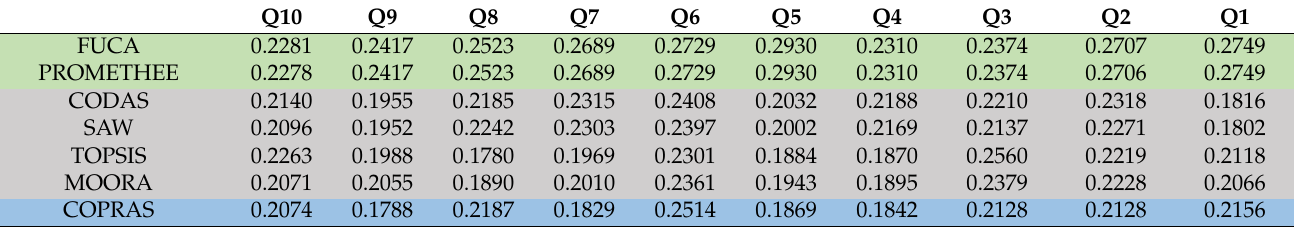
Table 7. SD Values of Firms’ MCDM based Financial Performance Scores (Green means the method is successful, gray means the method is mediocre, and blue means the method is